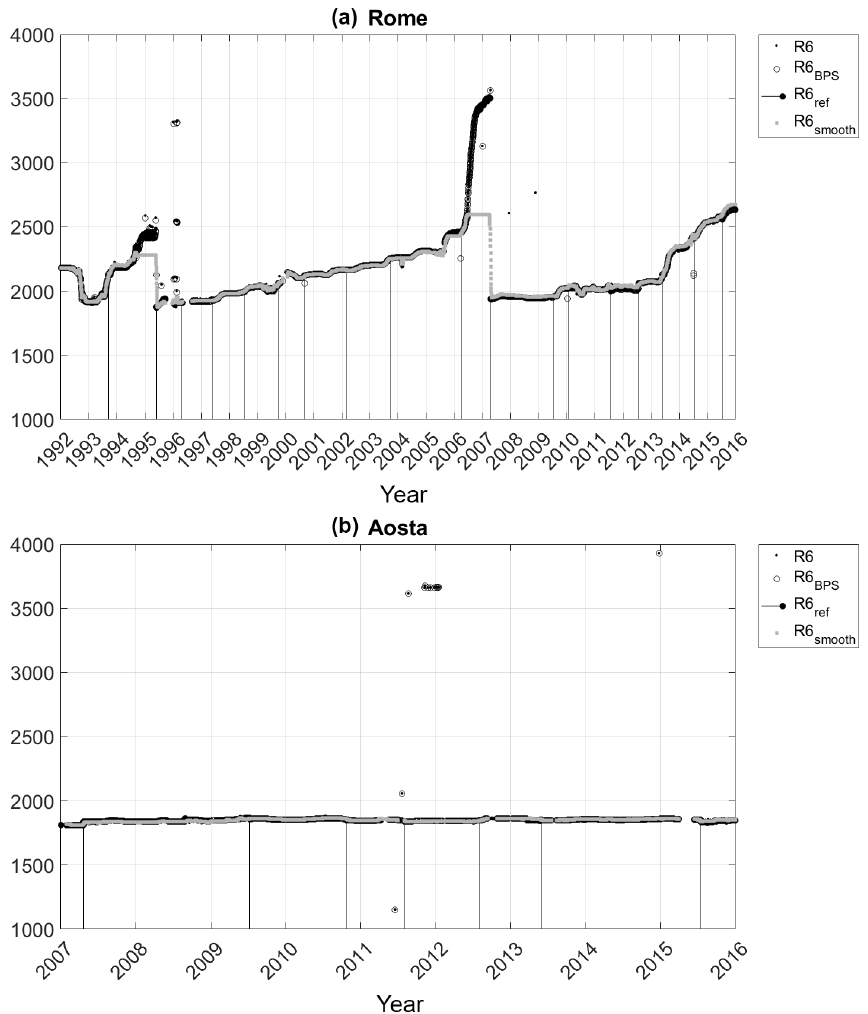
Figure 6. Daily series of the ratios R 6, R 6 BPS and R 6 smooth at Rome (a) and at Aosta (b) . Vertical lines represent R 6 ref established during each calibration campaign. BPS discarded the two spikes in December 2007 and December